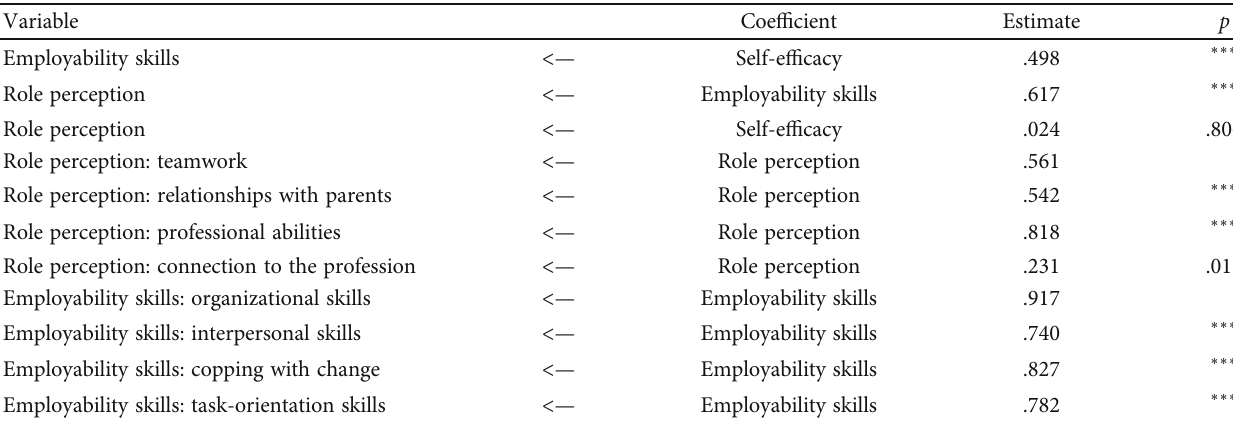
Figure 2: Analysis results of conceptual model mediation. Coe ffi cients in bold are signi fi cant at p < 0 : 05 . Table 2: Model coe ffi